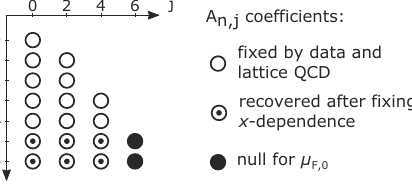
Fig. 1 The sketch indicates three groups of the polynomiality expan- sion coefficients, A n , j , appearing in the modelling after fixing the trun- cation parameter to N = 4. The coefficients that we assume to be constrained by data and lattice QCD are denoted by (cid:2) , those that are null, but only at the initial factorisation scale are denoted by (cid:3) , while those calculable from (cid:2) after fixing the recovery of x -dependence are denoted by